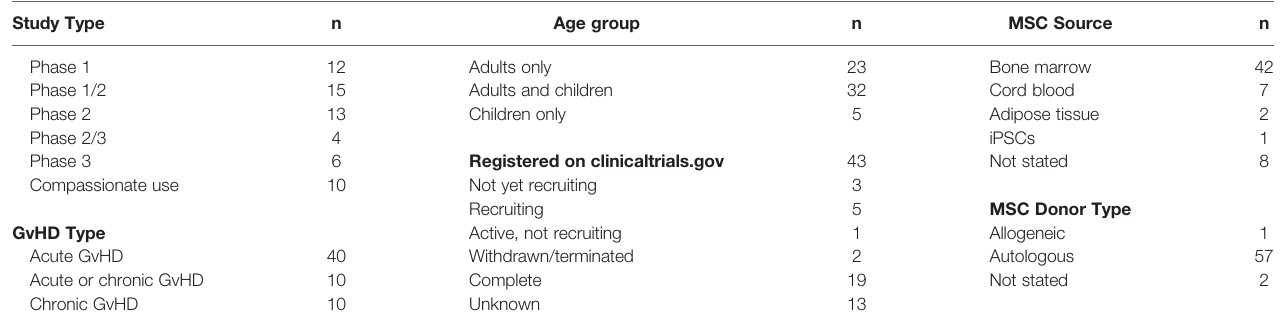
TABLE 1 | Overall Summary of Characteristics of Clinical Studies of MSCs in GvHD (n = 60). Study Type